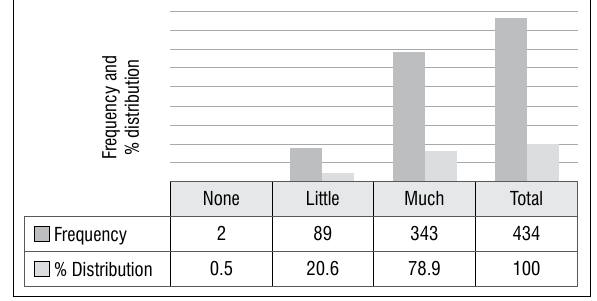
Figure 6: Community perceptions of the climate impacts on local wetlands ( n =434).